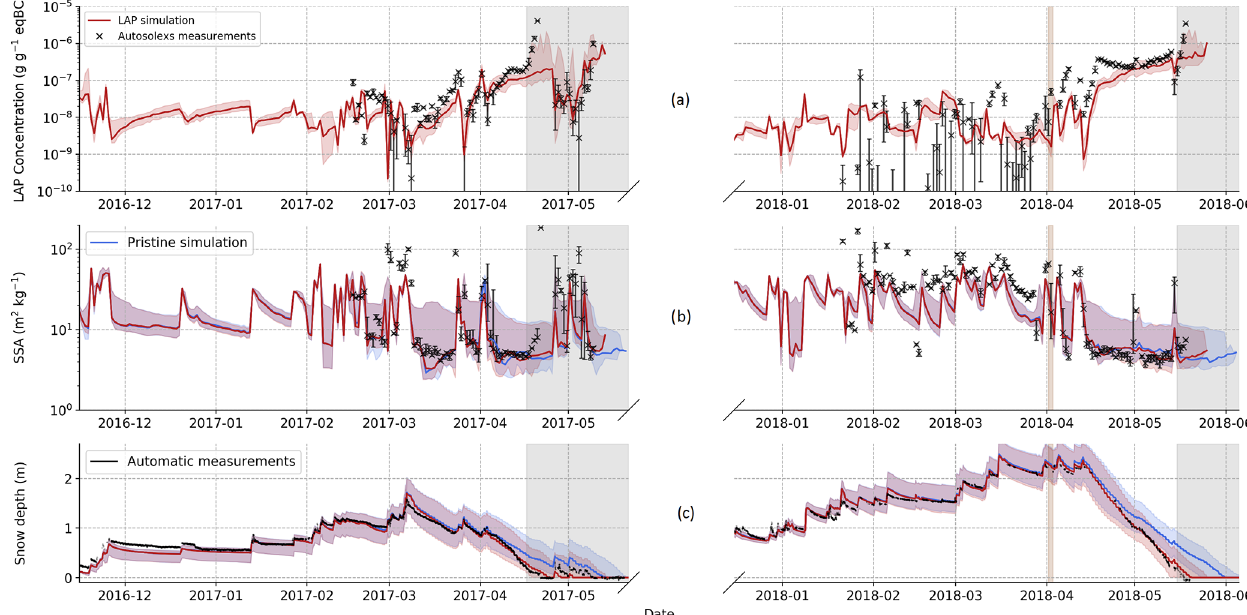
Figure 5. Evolution of measured and simulated near-surface AEC (a) , near-surface SSA (b) and snow depth (c) . Ensemble simulation results are represented with a shading, and the median value of the different simulations is represented with a full line. The information retrieved from automatic spectral albedo (Autosolexs) is represented by black crosses with error bars corresponding to the 25% and 75% quantile of all the measurements of the day. The major dust deposition of the second year is represented by brown shading, and grey shading corresponds to areas with less than 20cm of measured snow